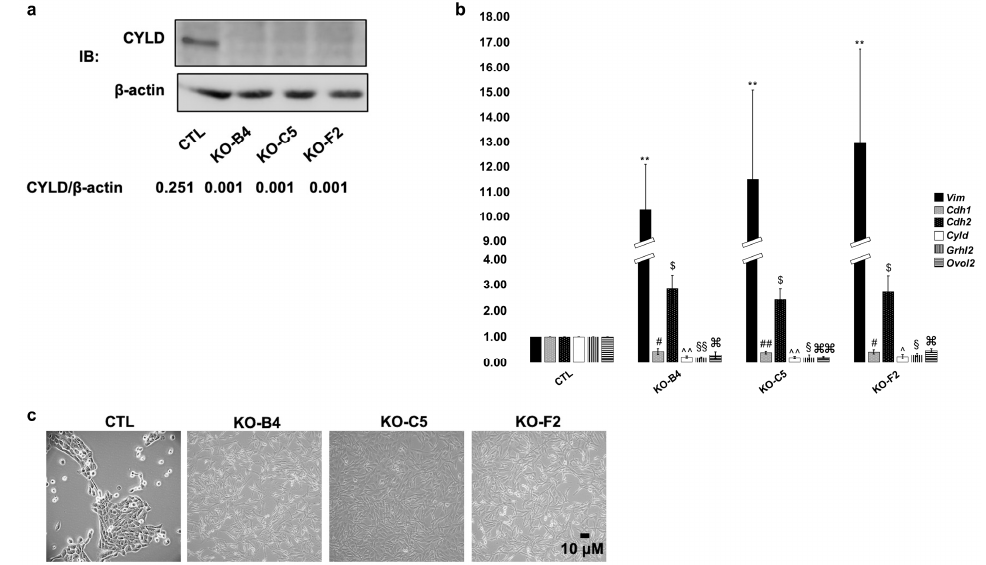
Figure 1. Introduction of CYLD-inactivating mutations in MCF10A cells induces EMT-like changes. ( a ) MCF10A cells were infected with lentiviral vectors expressing Cas9 and gRNAs that target the GFP gene (control gene) or exons two, three, or nine of the CYLD gene. Whole cell lysates extracted from control (CTL) and CYLD-targeted (B4, C5, and F2) clones were isolated and analyzed by immunoblotting for the expression of CYLD and β -actin. The indicated ratios of band intensities are shown below the corresponding lane. ( b ) Genetic inactivation of CYLD leads to reduction of E-cadherin (Cdh1), Grainyhead Like Transcription Factor 2 (Grhl2), and Ovo Like Zinc Finger 2 (Ovol2), and upregulation of Vimentin (Vim) and N-cadherin (Cdh2) mRNA expression levels. Total RNA was extracted from the MCF10A clones analyzed in A and used to determine the relative levels of the indicated mRNAs by qPCR. The histogram indicates the average values (+/ − SE) of relative mRNA levels as determined by the ΔΔ C T method and tyrosine 3-monooxygenase/tryptophan 5-monooxygenase activation protein zeta ( YWHAZ ) as the endogenous control from at least three independent experiments. The statistical analysis of relative mRNA expression pairwise comparisons between the control clone and each one of the CYLD-deficient clones was performed by the Student’s t -test method. ($, #, ^, §, ⌘ : p ≤ 0.05, **, ##, ^^, §§, ⌘⌘ : p ≤ 0.01). ( c ) Representative pictures of the MCF10A clones analyzed in ( a ).